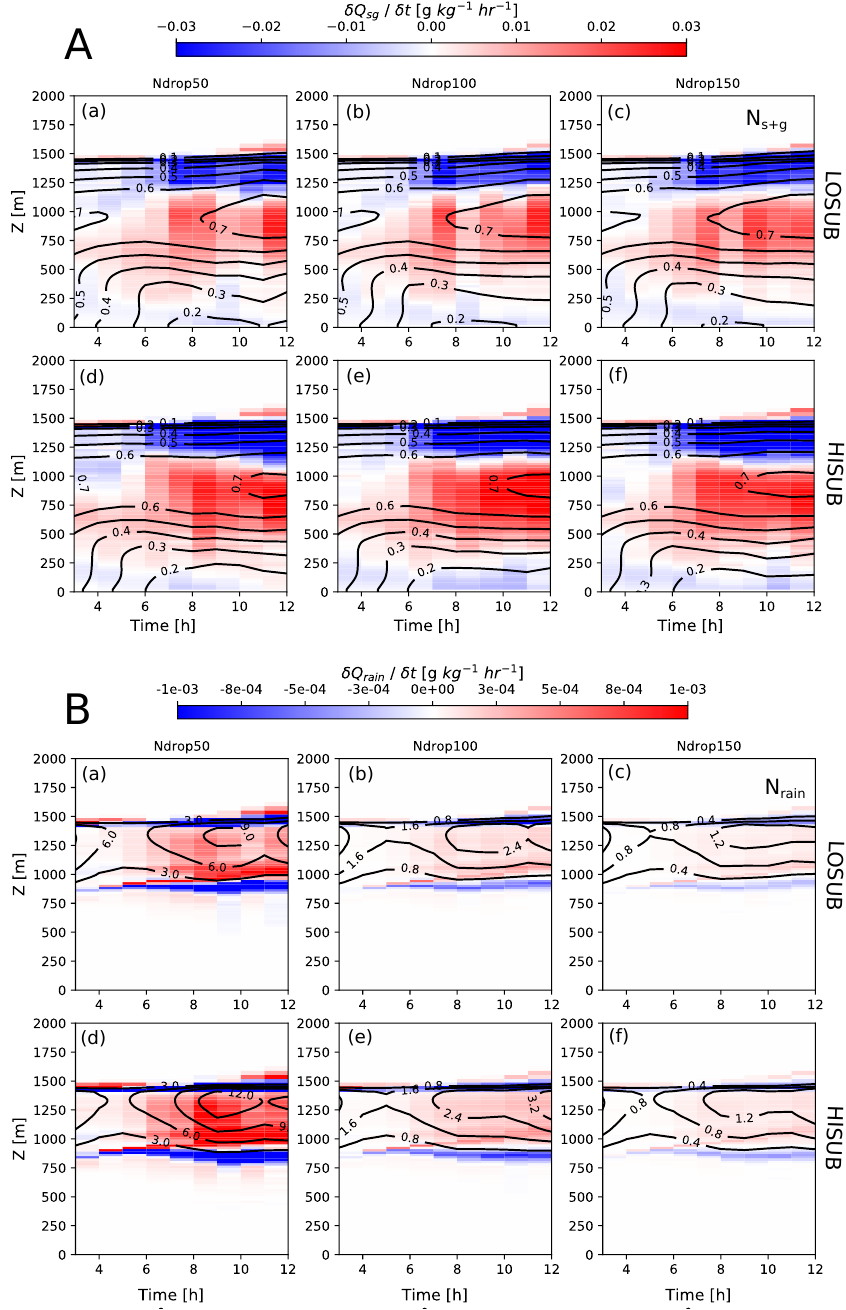
Figure 5. A: change in δQ sg /δt (gkg − 1 h − 1 ) (shading) between subsidence cases and the corresponding CNTRL simulation for test 2. Red corresponds to increased production, whilst blue shows increased sublimation relative to the associated CNTRL. N sg (L − 1 ) is shown as contours. B: as panel A, instead the change in δQ rain /δt (gkg − 1 h − 1 ) is shown with N rain (L − 1 ) as contours. (a–c) LOSUB, (d–f) HISUB.